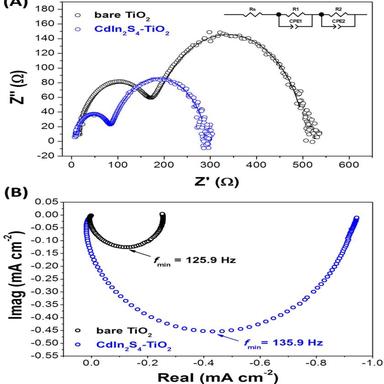
(A) Nyquist plots, and (B) IMPS plots of the (a) bare TONR/FTO photoanode, and (b) (×4)-CdIS/TONR/FTO photoanode measured at −0.5 V vs. Ag/AgCl under 1–sun illumination condition, using (Na2S+ Na2SO3) mixed sulfide electrolyte. The inset shows the equivalent circuit model used to fit the Nyquist plot.